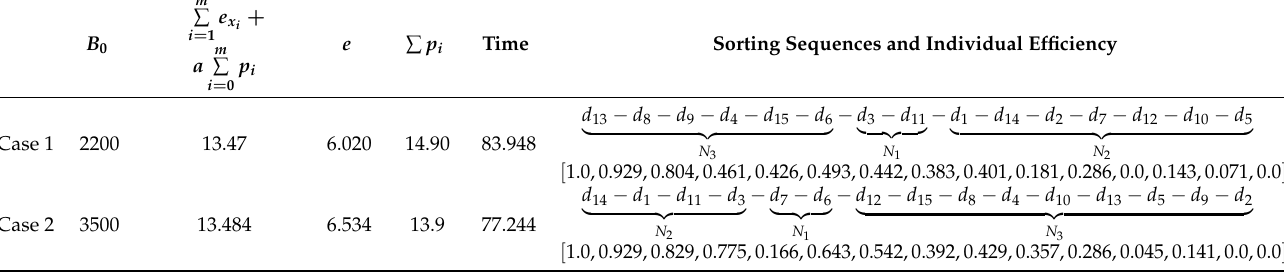
Sorting Sequences and Individual Efficiency